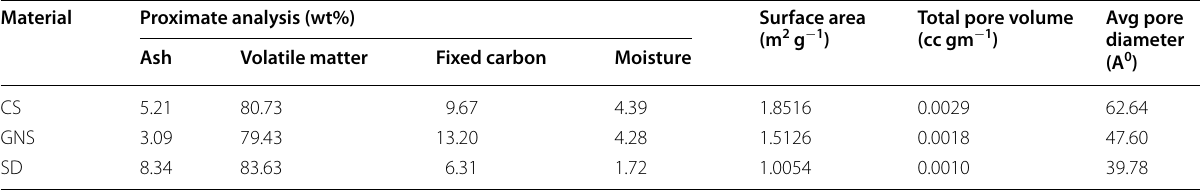
Table 1 Proximate analysis of CS, SD and GNS on dry basis